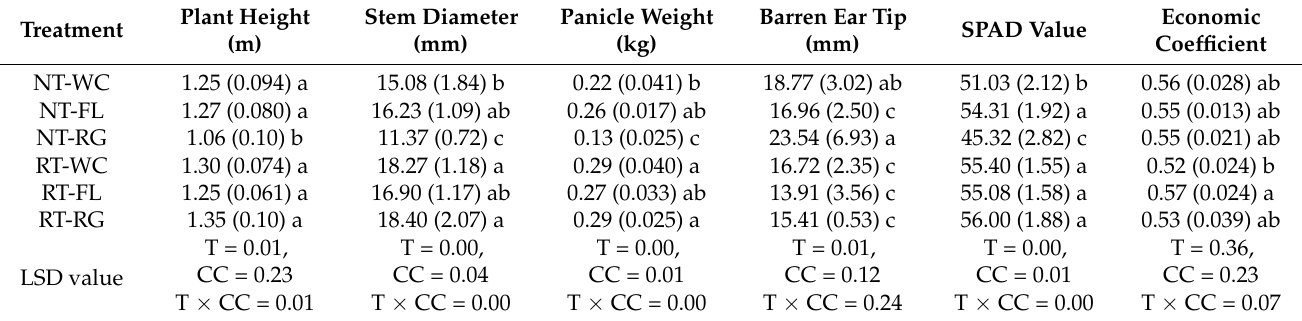
Table 2. Effects of different tillage methods and treatment of cover crop on physiological indexes of corn [mean (SD); n =